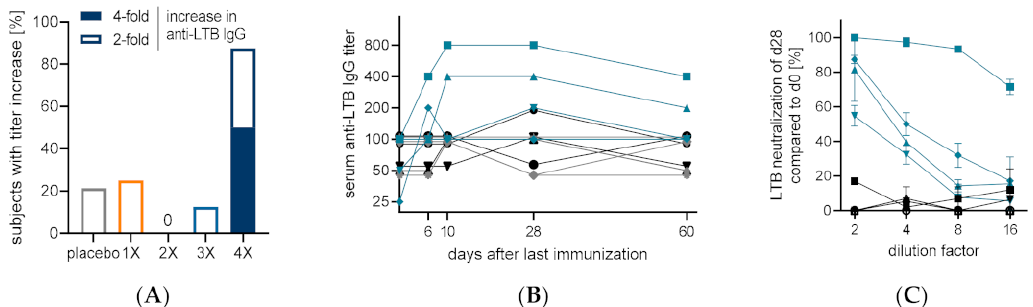
Figure 6. Serum anti-LTB IgG responses and LTB neutralization capacity. ( A ) Percentage of subjects responding with an at least 4-fold (solid) or at least 2-fold (open) titer increase in anti-LTB IgG in serum at any analyzed time point in groups receiving indicated numbers of doses of 5 × 10 10 CFU oral ShigETEC or placebo (grey). ( B ) Individual anti-LTB serum IgG titers of all subjects in group 2C (4-dose regimen) with placebo recipient in grey, vaccinees with <4-fold titer increase in black and vaccinees with >4-fold titer increase in blue. ( C ) LTB neutralizing capacity of serum of all subjects of group 2C (4-dose regimen) at indicated dilution